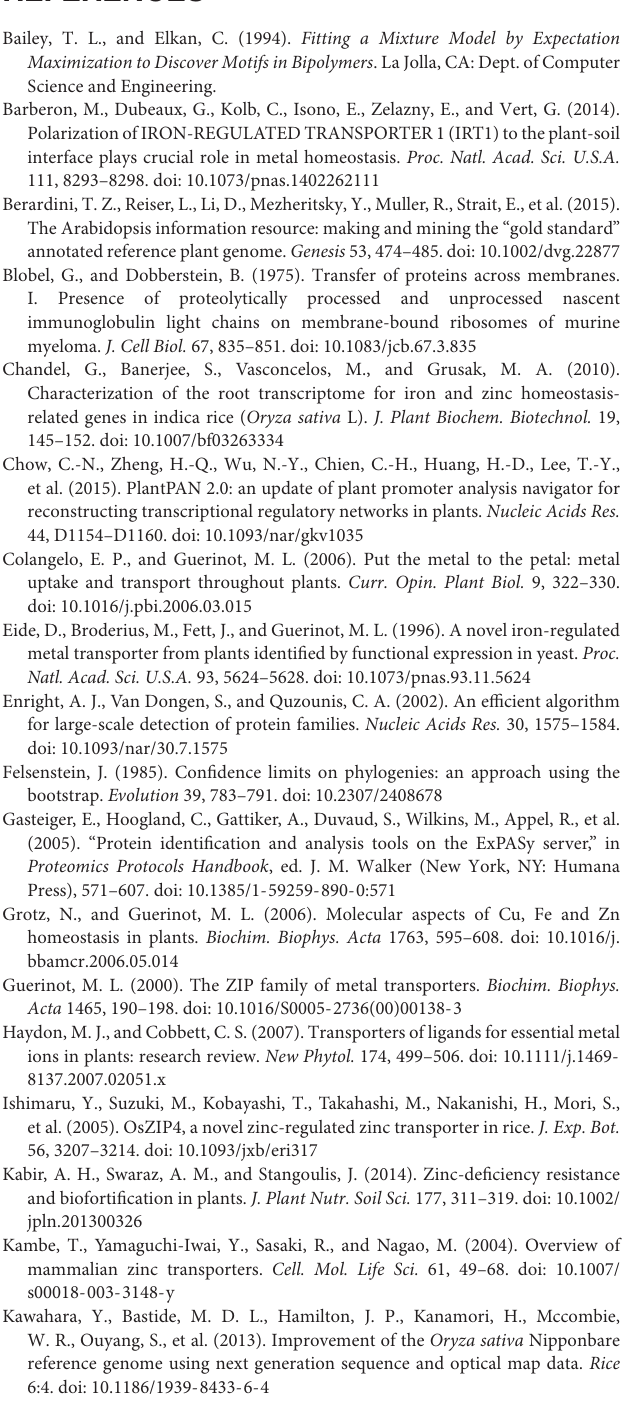
FIGURE S2 | Homology modeling of 7 SiZIPs as predicted by SWISS-MODEL given in 3-D structure. FIGURE S3 | Motif analysis has been done among the 12 single copy ortholog ZIP gene family members of Arabidopsis, rice and foxtail millet. The different color bars in one gene indicate different motifs.